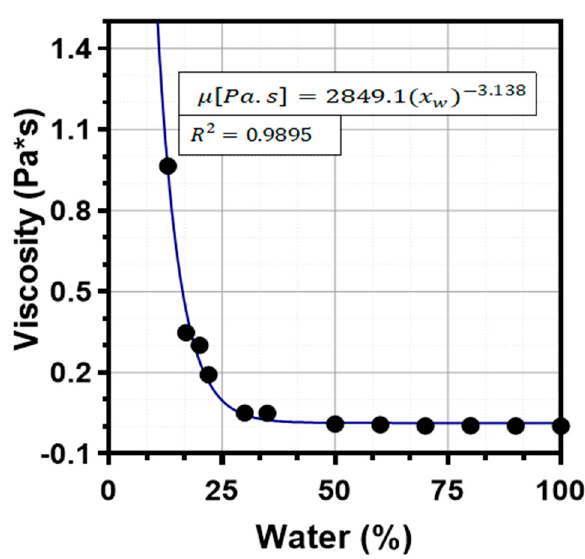
Figure A2. Glycerin viscosity as a function of the percentage of water.